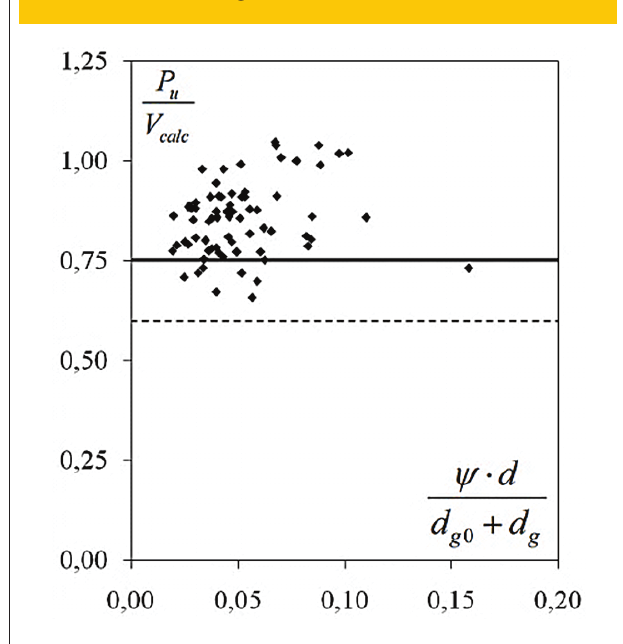
Figure �� � Com�arison of results from database with those using recommendations of